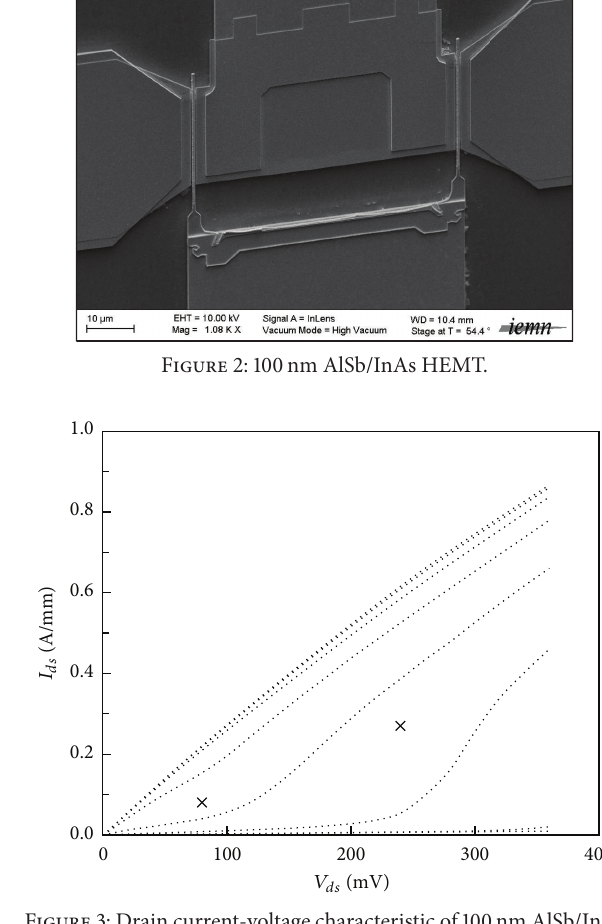
Figure 3: Drain current-voltage characteristic of 100nm AlSb/InAs HEMT. 𝑉 𝑔𝑠 is varying from 0 V to − 1.4V with − 0.2 V step. (Crosses are polarisation conditions for measurements at peak 𝑓 𝑇 ).